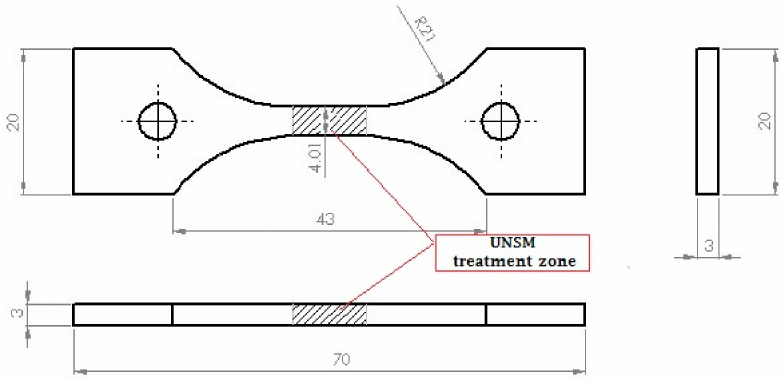
Figure 1. A schematic view of a tensile test specimen.